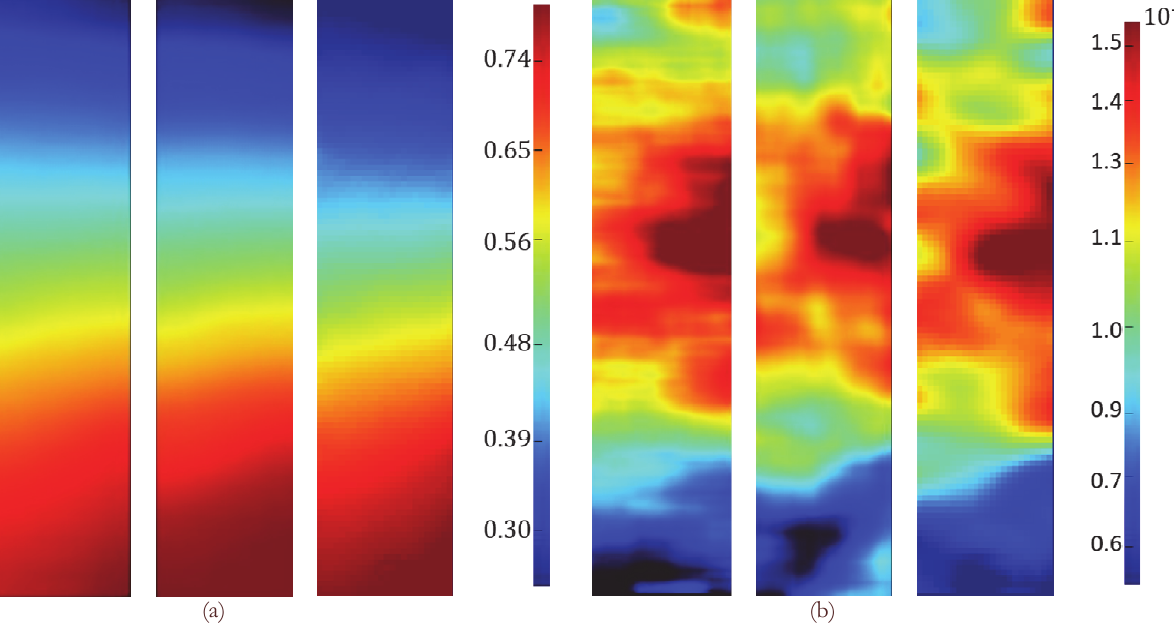
Figure 3: Asphalt mixture sample 2: results computed, in order of appearance, with LSM, SGM, NCORR. (a) Map of the displacement along X axis [mm]; (b) Map of the strain along X axis